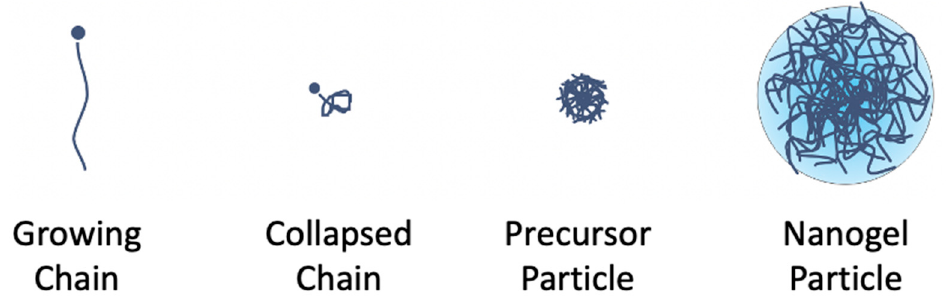
Figure 2. Schematic of the various stages of nanogel growth during precipitation polymerization involving pNIPAm chain growth, which collapse upon reaching a critical chain length. The collapsed chains then serve as precursor particles for growth, resulting in a stable microgel.